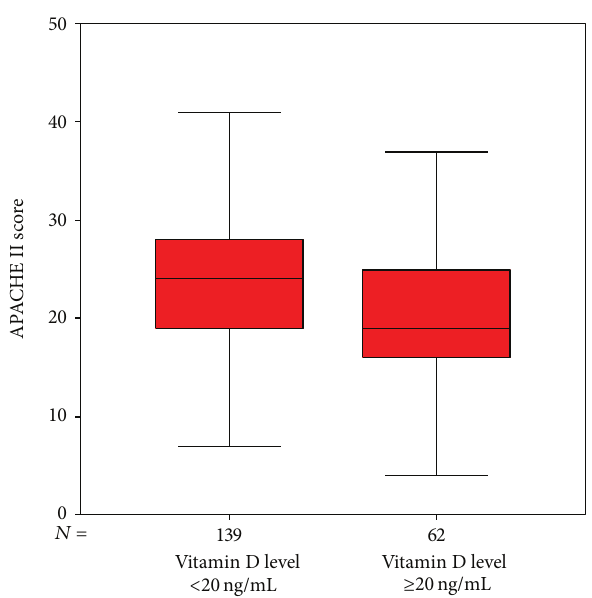
Figure 3: APACHE II scores of vitamin D sufficient and insufficient groups (𝑃 = 0.006)